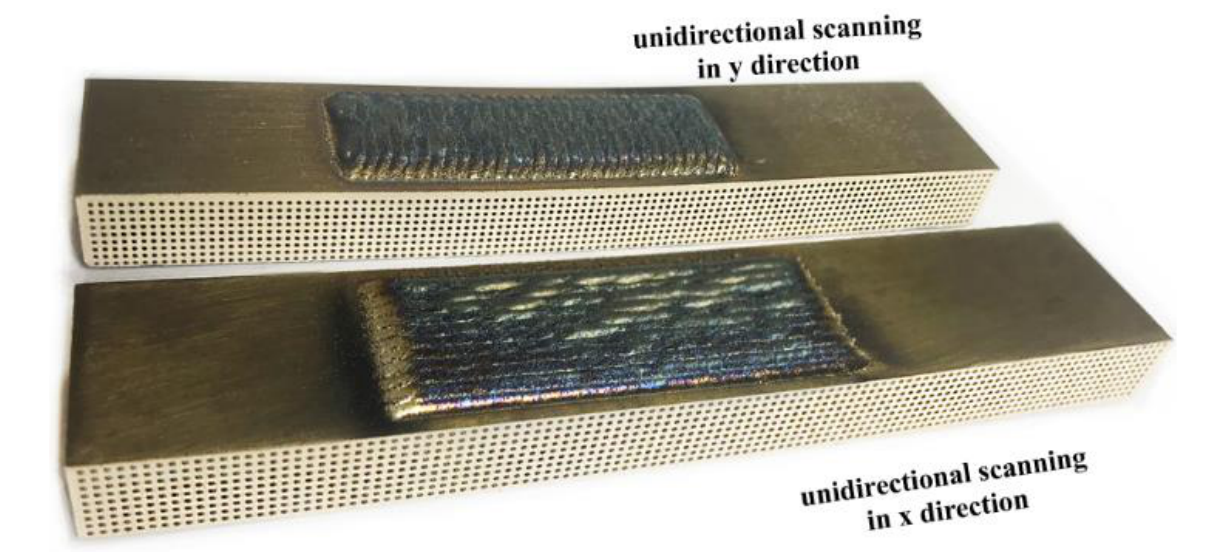
Figure 9. Grid lines state after cladding at 5 mm/s scanning speed.